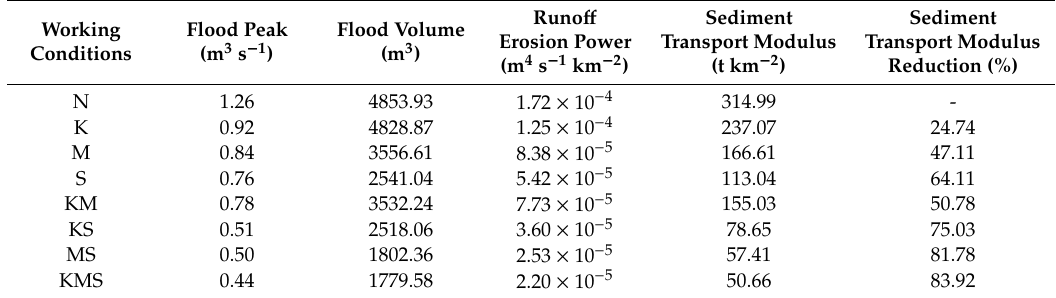
Figure 6. Relationship between runoff erosion power and sediment transport modulus of individual storms in the Wangmaogou watershed. Table 5. Calculated sediment transport modulus for different dam type combinations.